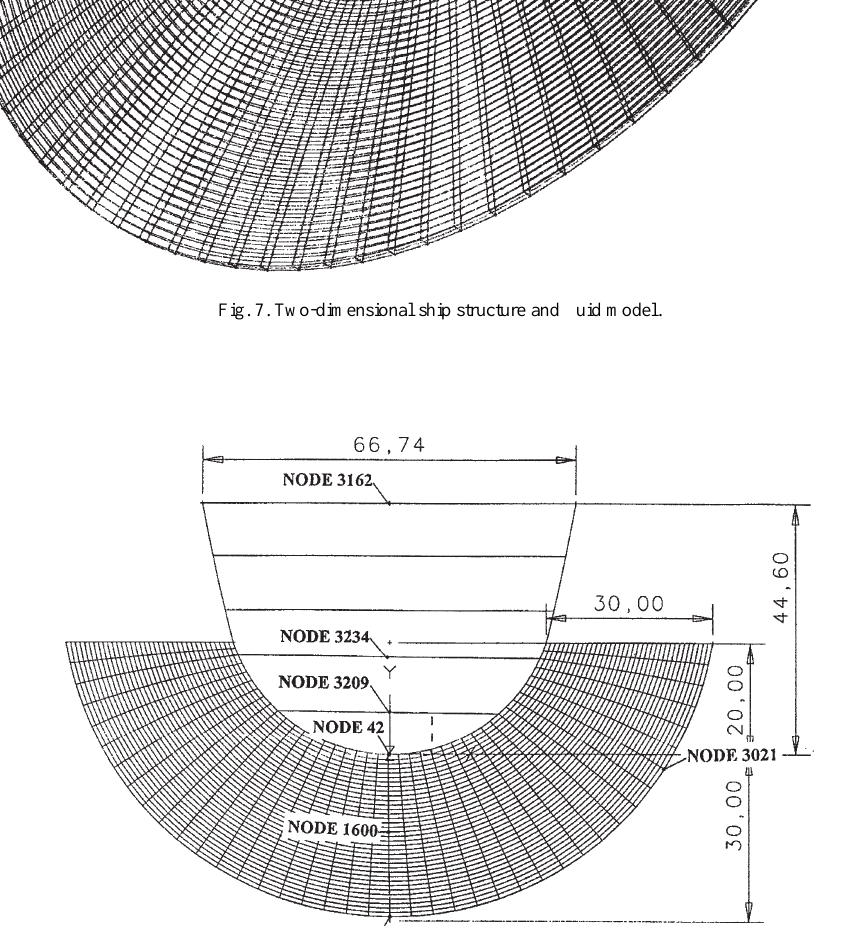
Fig. 8. Node IDs and dimensions of ship structure and fluid model (unit =